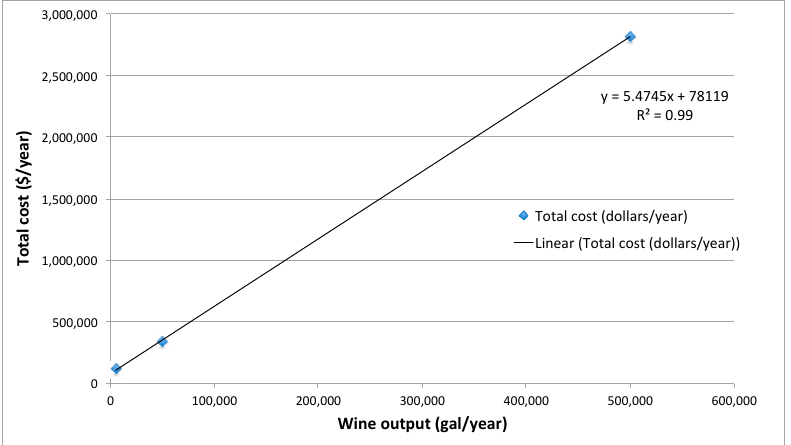
Figure 4. Annual production costs according to scale of operation (showing exponential trendline).